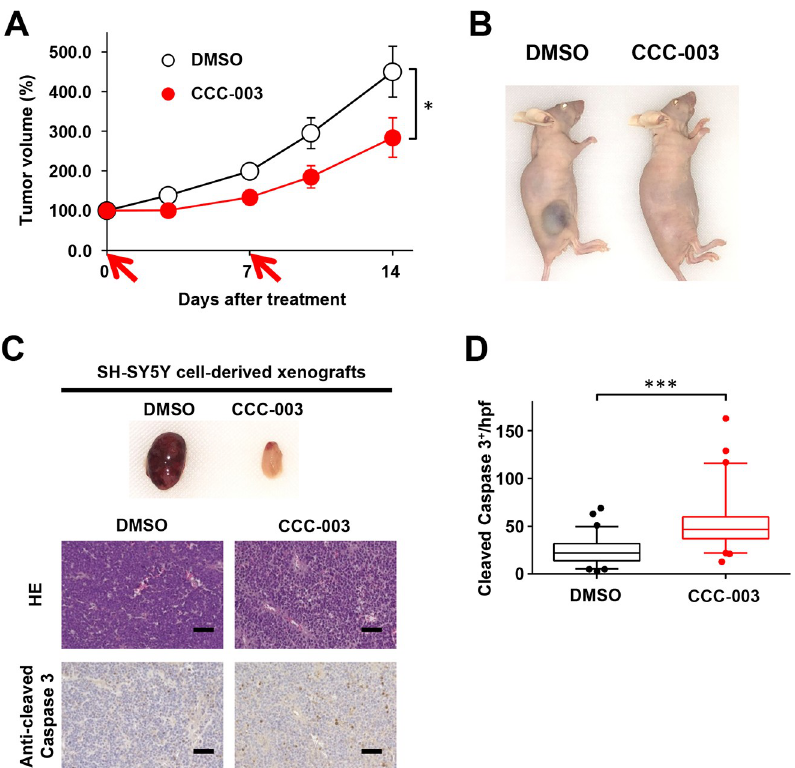
Fig 6. CCC-003 suppresses tumor growth in human ALK -mutated neuroblastoma xenograft models. (A, B, C) SH-SY5Y cells were subcutaneously injected into the flanks of female immune-deficient BALB/c nu/nu mice. Administration of CCC-003 began when the average tumor size reached 500 mm 3 . (A) The tumor volume of mice was measured twice a week. Red arrows indicate the timepoints of CCC-003 administration. P -values were determined using repeated measures ANOVA followed by a Bonferroni post-hoc test ( � , P < 0.05). Data are presented as the mean ± SD. DMSO was used as a control. (B) Representative images of mice with SH-SY5Y xenografts at 24 h after administration. (C) Representative images of SH-SY5Y xenograft tumors at 24 h after administration. At 24 h after administration, the tumor tissues were collected and used for immunohistochemistry with HE and an anti-cleaved caspase-3 antibody. Scale bars, 50 μ m. (D) The number of cleaved caspase-3-positive cells was determined in tumor tissues. P- values were determined using a paired t -test ( ��� , P < 0.001).